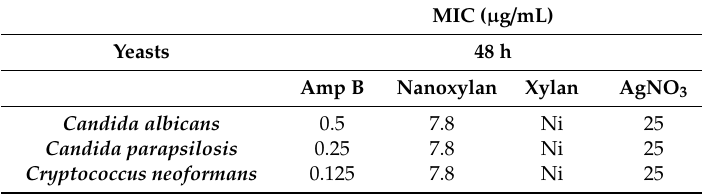
Table 3. Minimal inhibitory concentration (MIC) of Amp B (Amphotericin B), nanoxylan, xylan